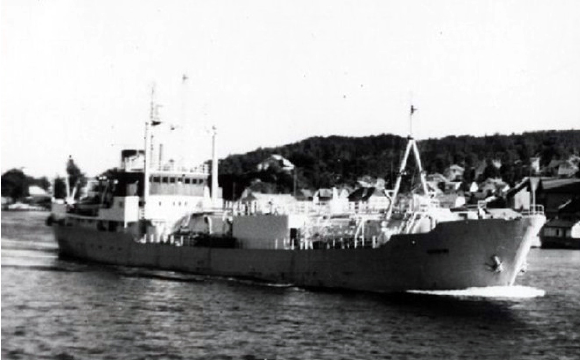
Figure 7: Norsk Hydro’s ammonia tanker M/S Haugvik is retrofitted with experimental automation technology to enable unmanned engine rooms. Courtesy of